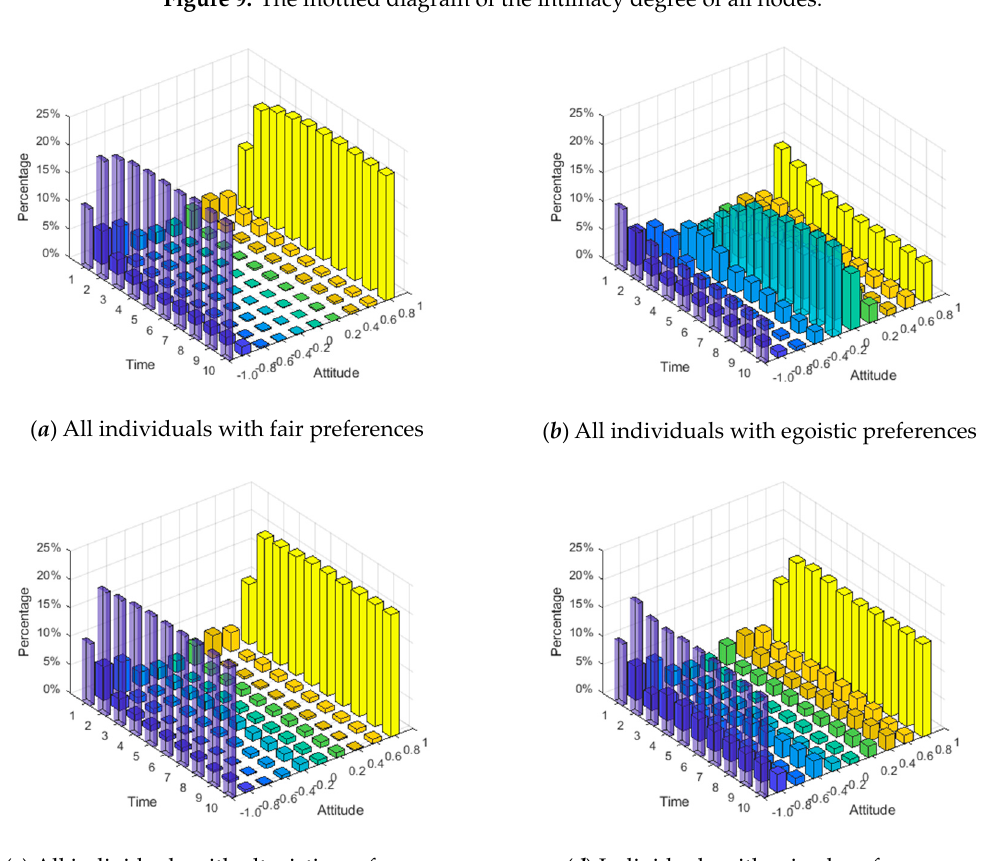
Figure 10. Attitude values of individuals at different times.